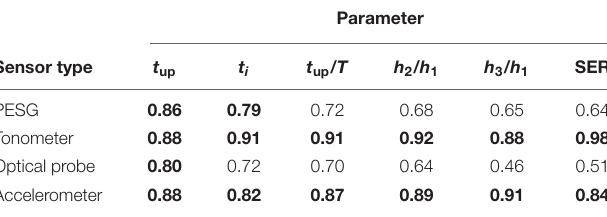
TABLE 5 | ICC of the derived parameters.